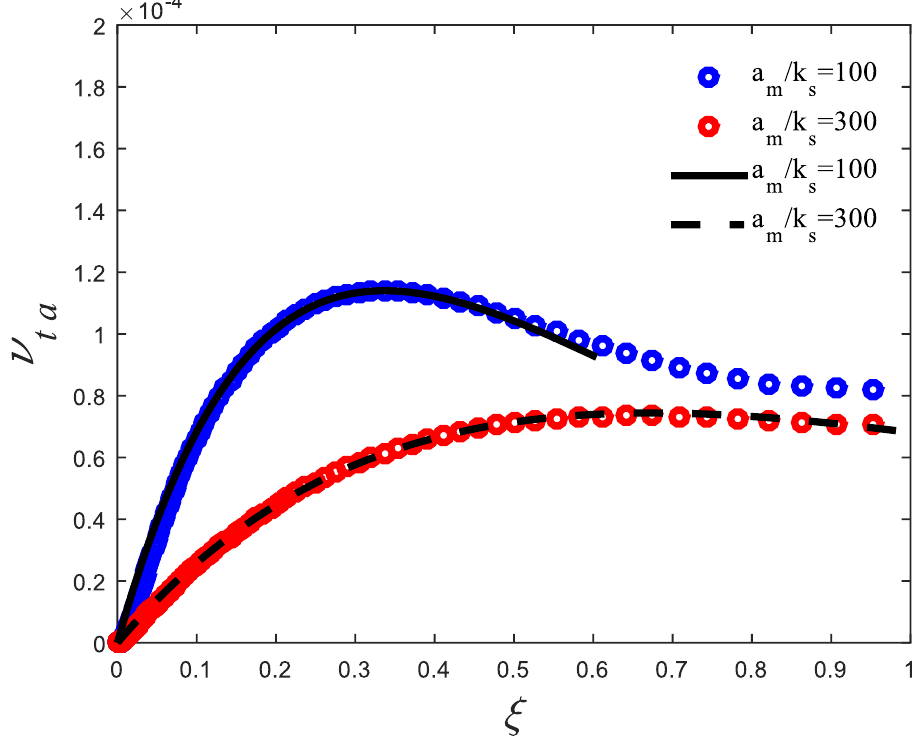
Figure 6. Period − averaged dimensionless eddy viscosity for a sinusoidal wave, curves: Equation Figure 6. Period-averaged dimensionless eddy viscosity for a sinusoidal wave, curves: Equation (4), (4), symbols: data from the BSL k- ω model, 𝑎 𝑚 /𝑘 𝑠 = 100 and 𝑎 𝑚 /𝑘 𝑠 = 300 . symbols: data from the BSL k- ω model, a m / k s = 100 and a m / k s = In our former study [36], the two parameters were calibrated by the BSL k- ω model up to 𝑎 𝑚 /𝑘 𝑠 = 500 . The values were